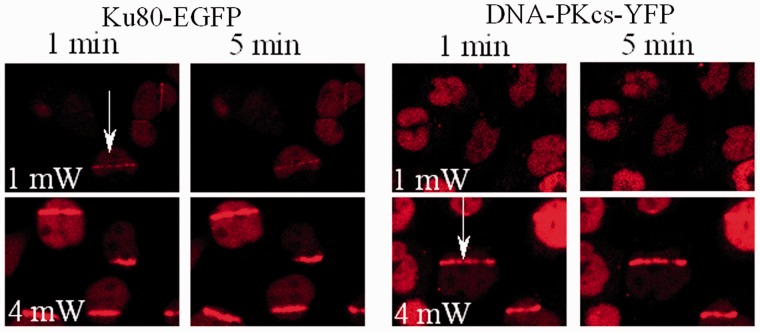
Power dependency of the intensity of fluorescence of Ku80-EGFP and DNA-PKcs-YFP at DSB induced in the, respectively, tagged cells following NIR microbeam irradiation with 730 nm photons (using a ×60 water microscope objective) at 37°C. Real-time confocal microscope images of the respective tagged proteins following NIR microbeam irradiation were taken at 1 min and 5 min following irradiation.